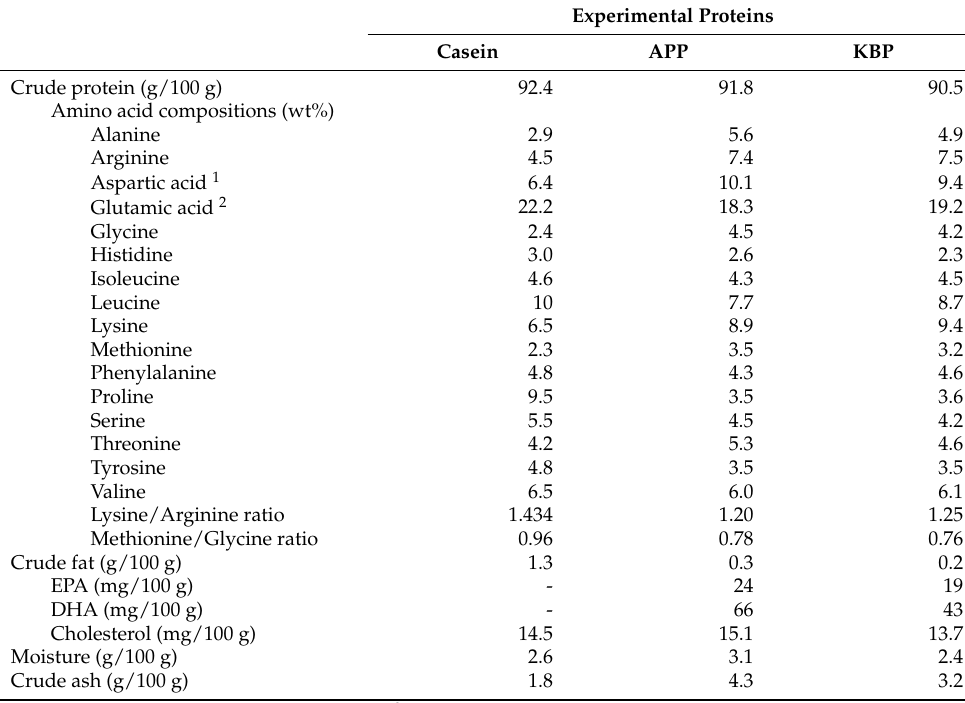
Table 2. Nutritional compositions of casein, APP, and KBP.